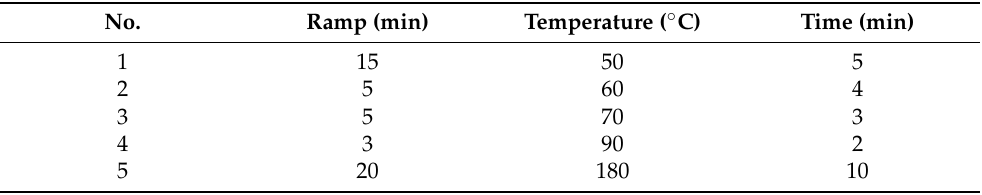
Table 2. Instrumental conditions of the microwave digestion process.